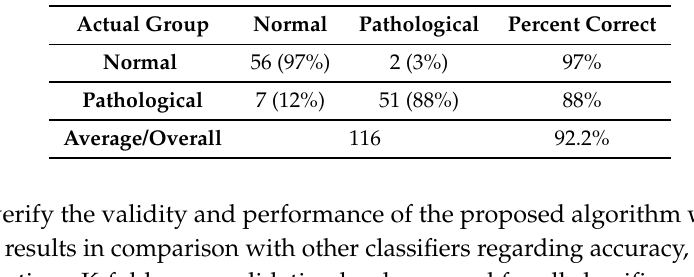
Table 1. Classification result of heart disease in newborns.